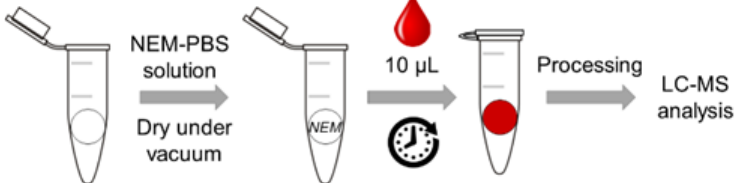
Figure 1. Paper card treatment with NEM, sample collection and processing scheme.